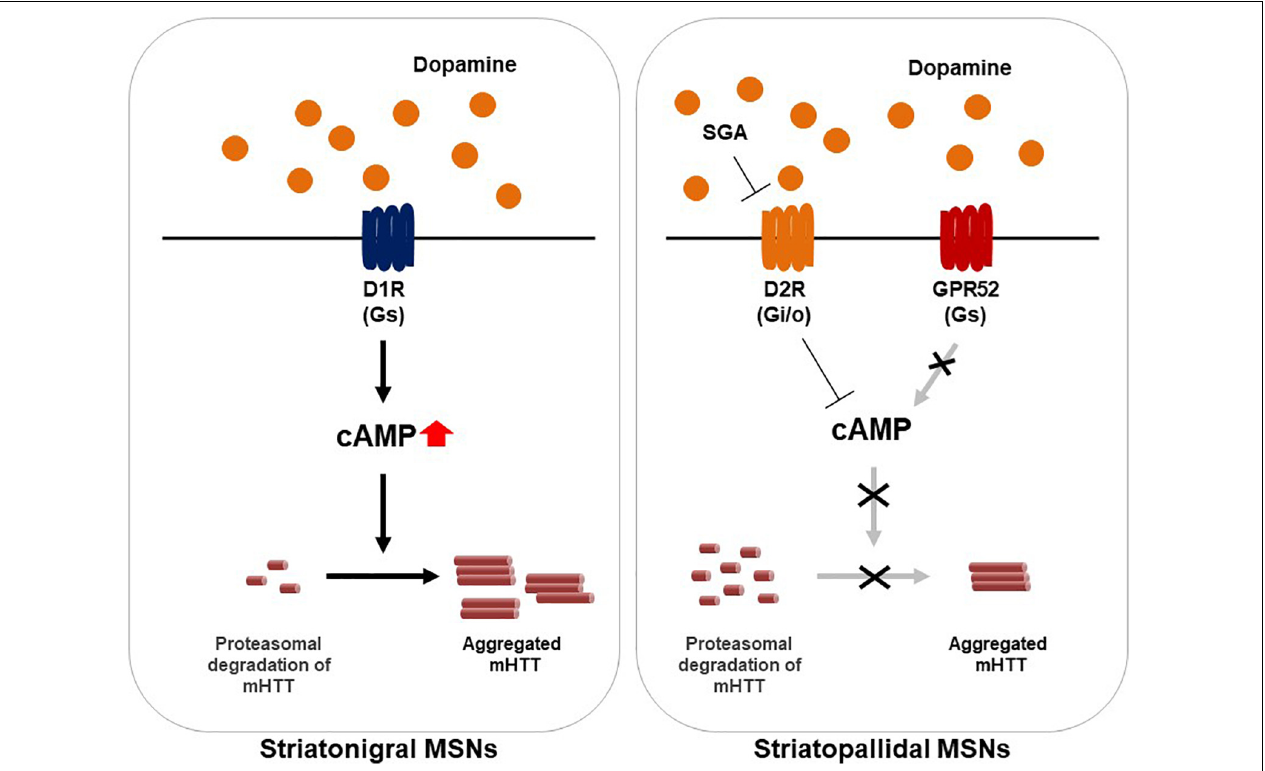
FIGURE 1 | A model illustrating of GPR52 inhibition for the treatment of Huntington’s disease. In the striatum, GPR52 is expressed in the striatopallidal MSNs in which dopamine D2 receptor (D2R) is expressed. GPR52 inhibition or the antagonists leads to proteasomal degradation of the mutant huntingtin protein (mHTT). Oppositely, GPR52 activation via intracellular cAMP rise transports mHTT to the endoplasmic reticulum and protects against its degradation. Meanwhile, GPR52 is not expressed in the striatonigral MSNs where dopamine D1 receptor (D1R) is expressed. Second generation antipsychotics (SGA), such as quetiapine, blocks D2R-mediated